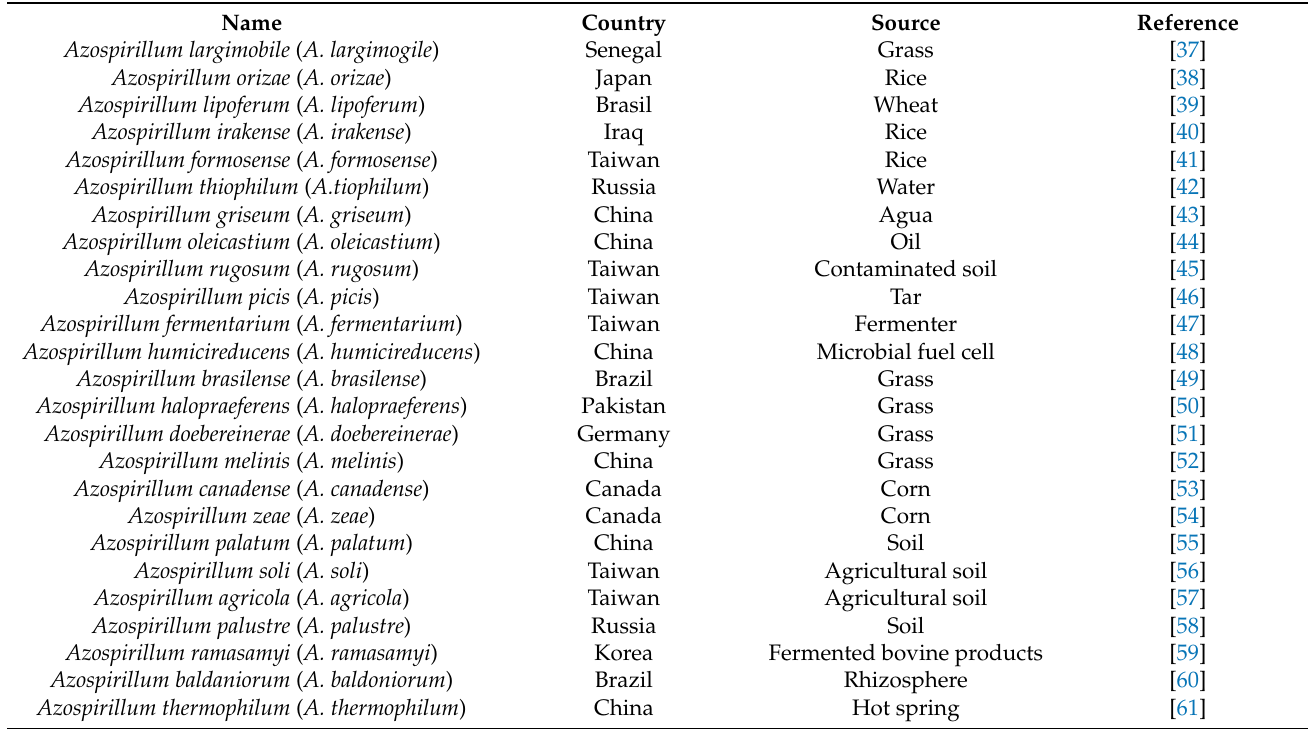
Table 1. Azospirillum species reported from different sources and